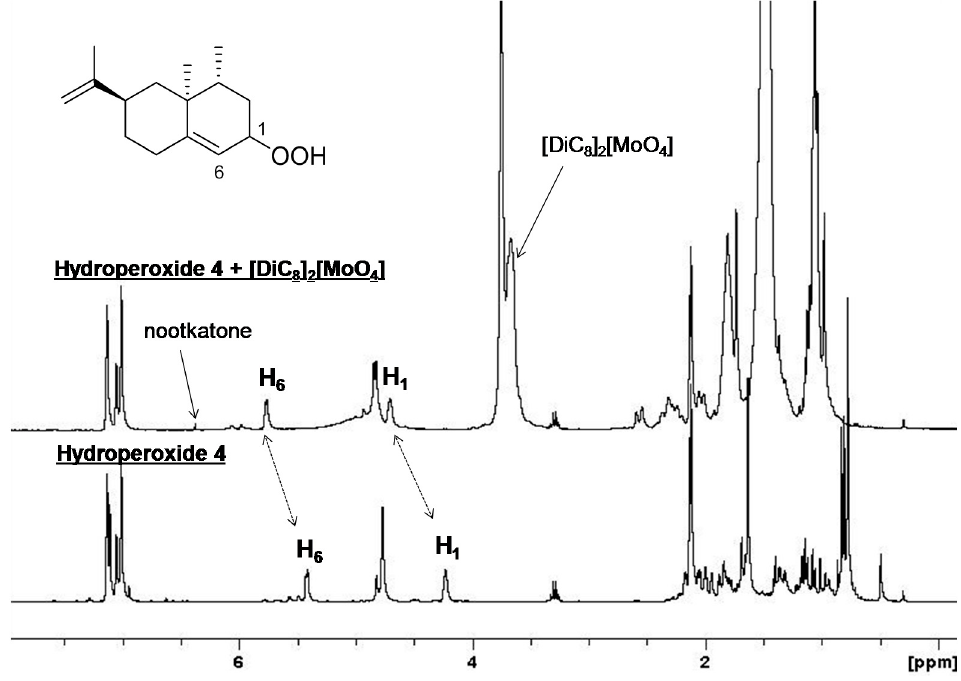
Figure 6. Evolution of the 1 H NMR spectrum of hydroperoxide 4 just after the addition of [DiC 8 ] 2 MoO 4 .